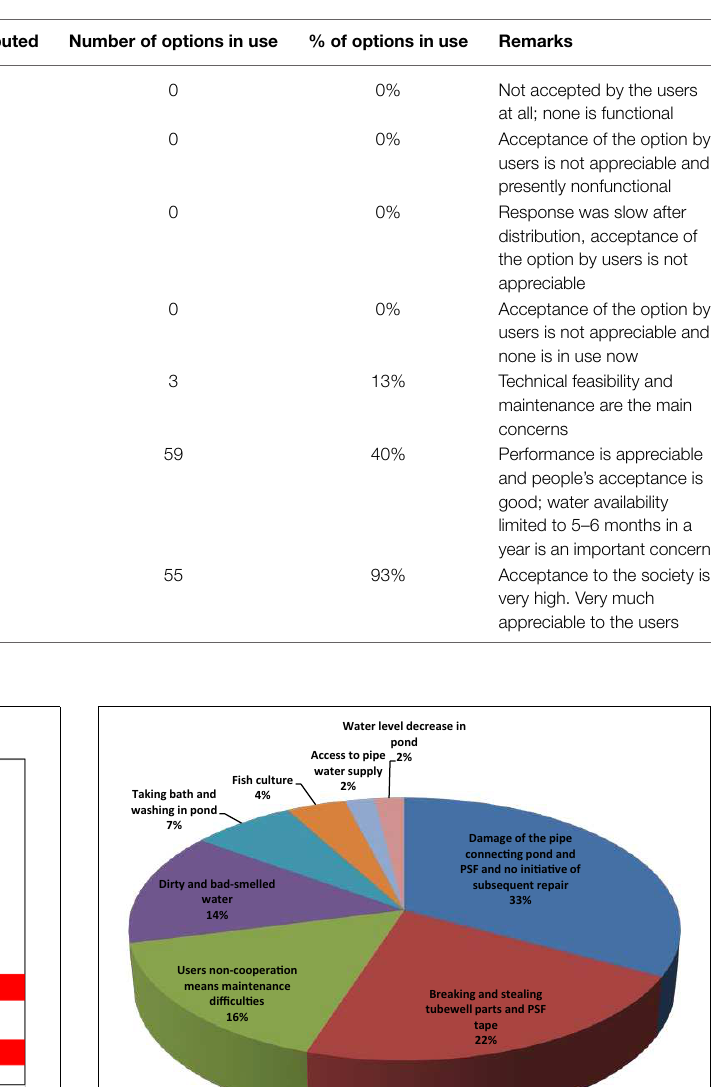
TABLE 7 | Current status of the safe water options distributed.